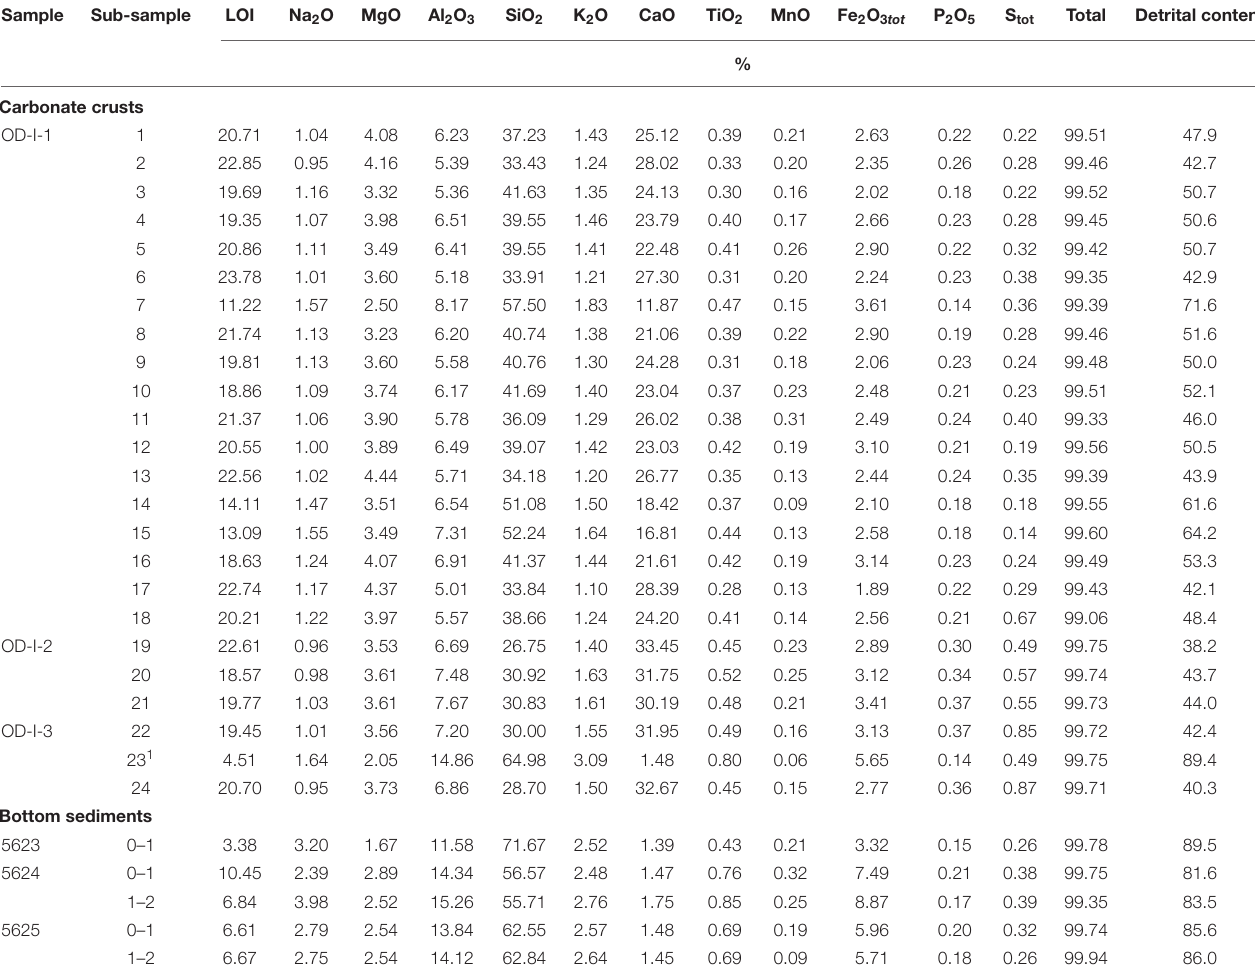
TABLE 3 | XRF major element composition of the carbonate crust and sediment samples.